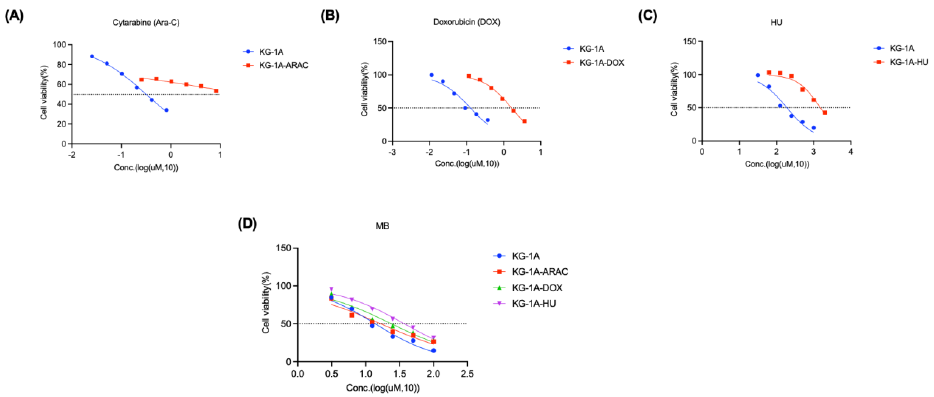
Figure 4. MB overcame drug resistance in AML cells. ( A – C ) KG-1A cells were treated with different doses of the compounds for 72 h and then cell viability was measured using MTT assays. ( D ) The antiproliferative effects of MB on the parental and resistant KG-1A cells were determined by per- forming MTT assays. Error bars represent SD. The resistant ratio = IC 50 for resistant cells/IC 50 for parent cells. Table 2 . Statistics of MTT IC 50 values.